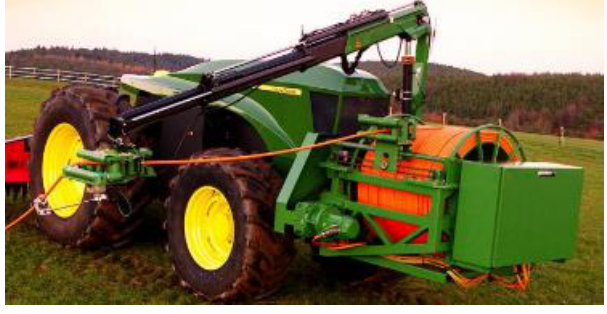
Fig. 27. John Deere GridCON [39]